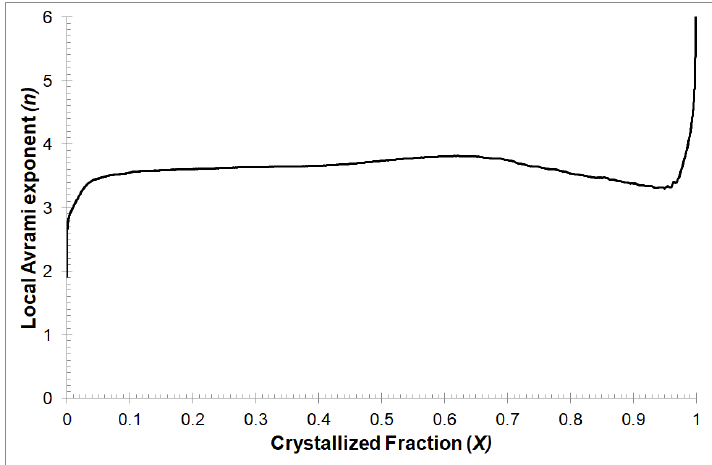
Figure 2. The local Avrami exponent n ( X ) varied with crystallized fraction X for isothermal annealing temperature equal to 507 K.